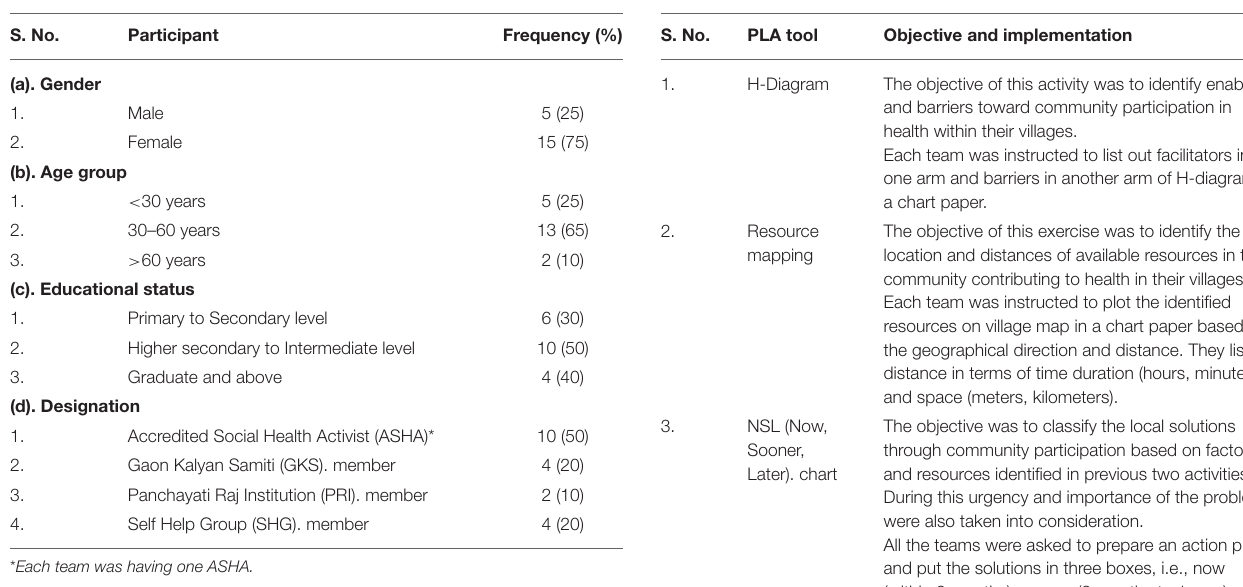
TABLE 1 | Characteristics of study participants ( n = 20). TABLE 2 | Summary and objectives of PLA